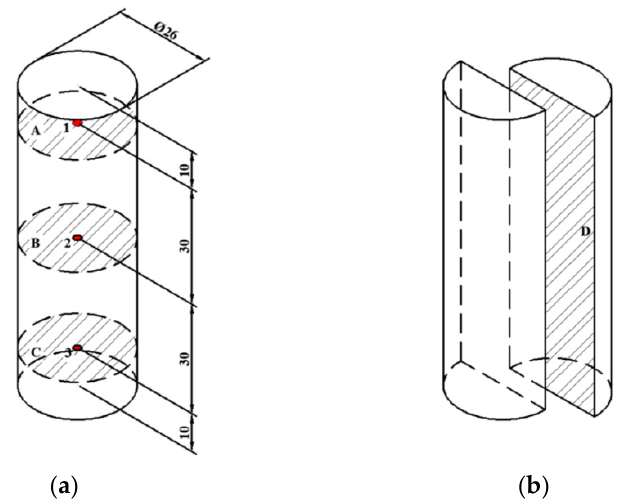
Figure 3. The location of fiber optic sensor (1, 2, 3) and four layers (upper, A; middle, B; lower, C; longitudinal, D) in the beef sausage sample for temperature distribution measurement (all measured in millimeters). ( a ) Detailed diagram of sample. ( b ) Longitudinal section of